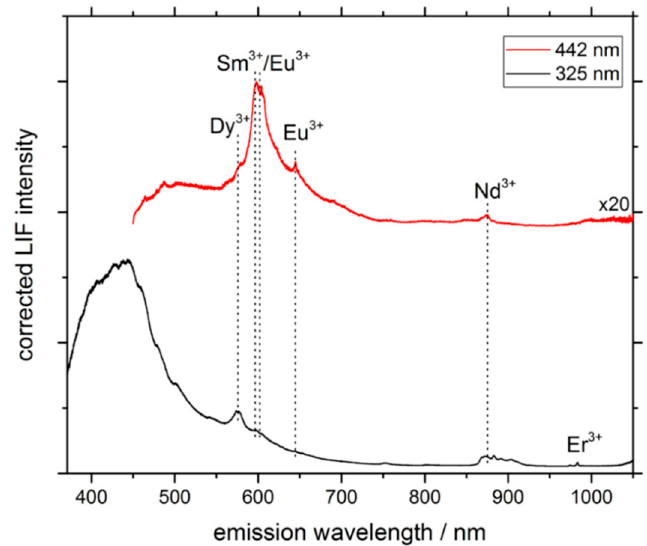
Figure 4. Comparison of LIF spectra from spot A on the Lofdal sample at an excitation wavelength of 325 nm (bottom) and 442 nm (top). Various REE-related signals are marked by dashed lines. Note the artificial enhancement of the spectral intensity for the 442 nm excitation by a factor of 20 and the offset for clarity.